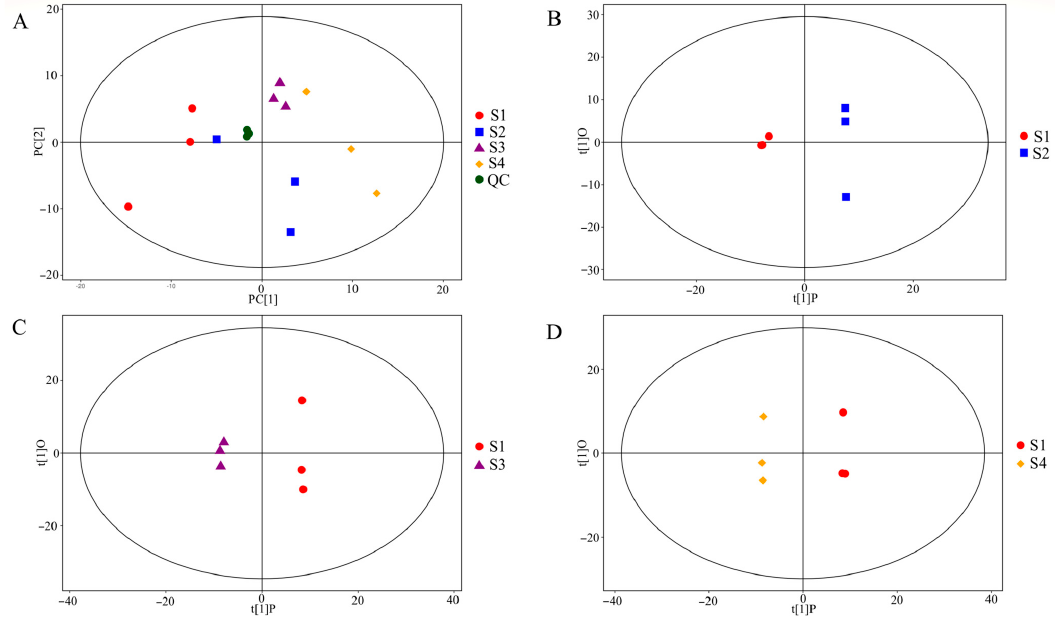
Figure 1. Multivariate analysis of seeds of C. vietnamensis . ( A ) PCA analysis of metabolic profiles from four sample groups and QC. ( B – D ) OPLS-DA models of seeds of C. vietnamensis at different maturity stages in positive and negative ion modes.